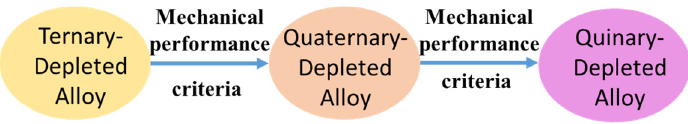
Figure 1. Alloy design path.